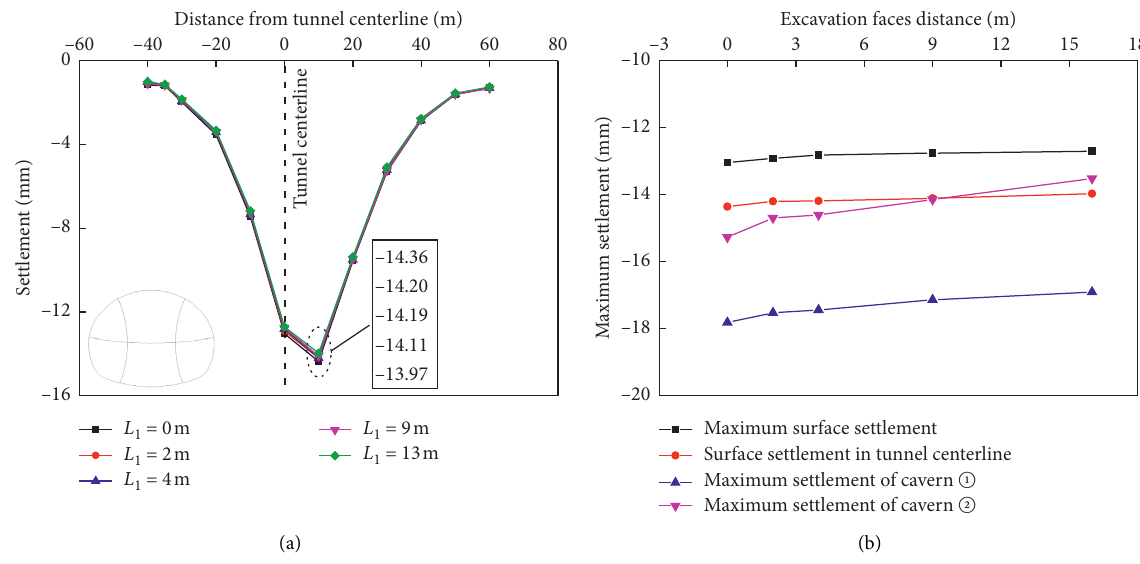
Figure 3: Surface settlement characteristics of CK9 +462 section. (a) Surface settlement curve. (b) Relationship between maximum vault settlement, surface settlement, and excavation face distance ( L 1